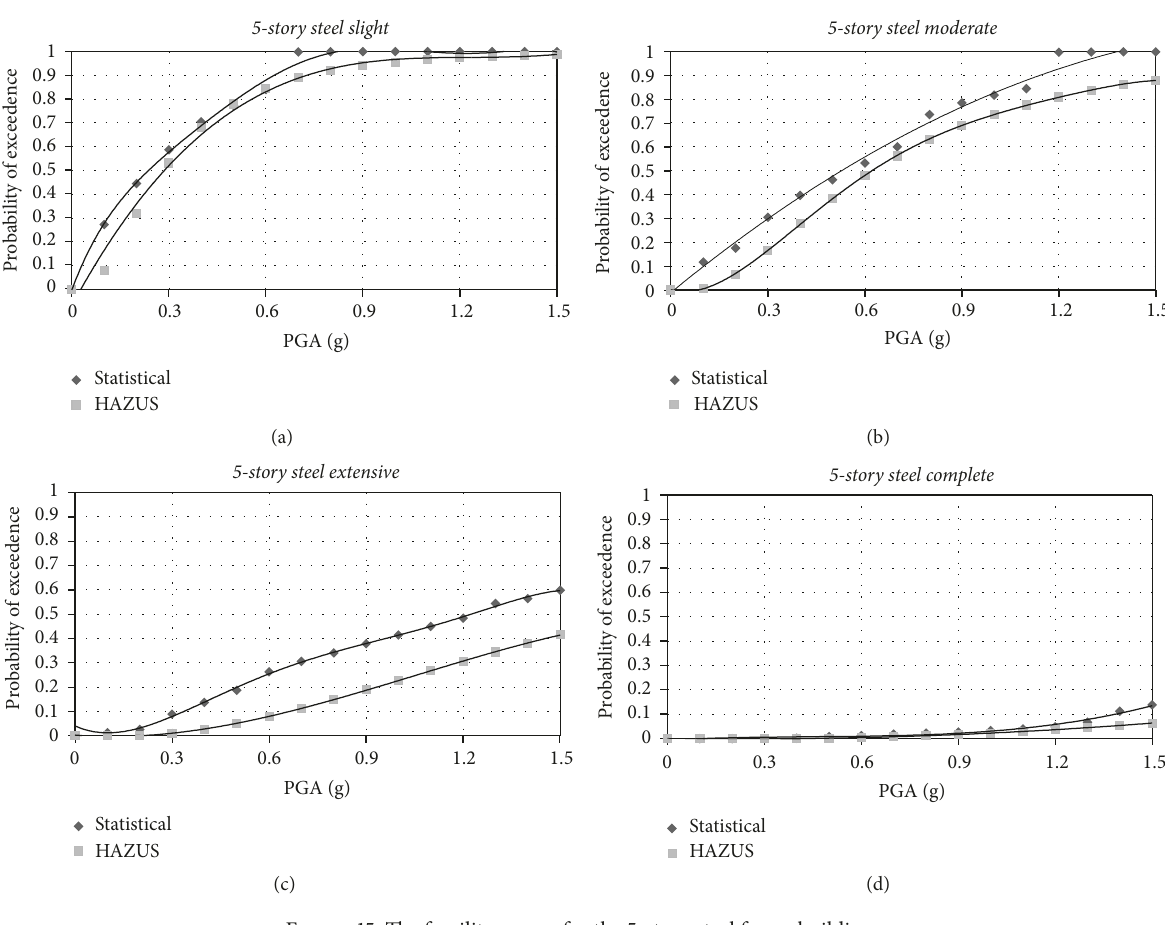
Figure 15: The fragility curves for the 5-story steel frame